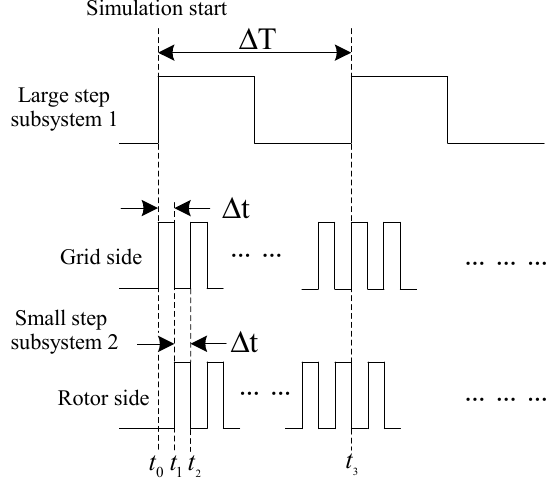
Figure 10. System and converter operation timing diagram.